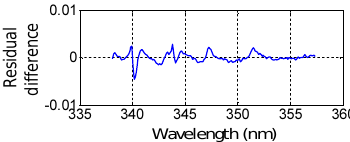
Figure 19. Difference between residuals of the standard DOAS fit and the fit with higher-order ozone terms included according to Puk¸¯ıte et al. (2010). The fit is performed for a SCIAMACHY mea- surement with the same observation geometry as for the sensitivity studies. Please note that a similar pattern is obtained for the simu- lated spectrum in the upper left plot in Fig. 16 illustrating the resid- ual for the initial DOAS fit where the higher-order terms are omit-